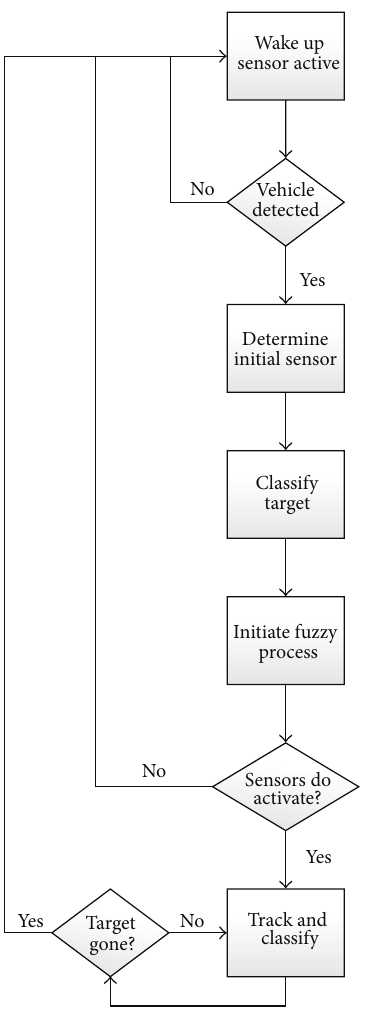
Figure 2: Battery consumption approach to sensor activation.